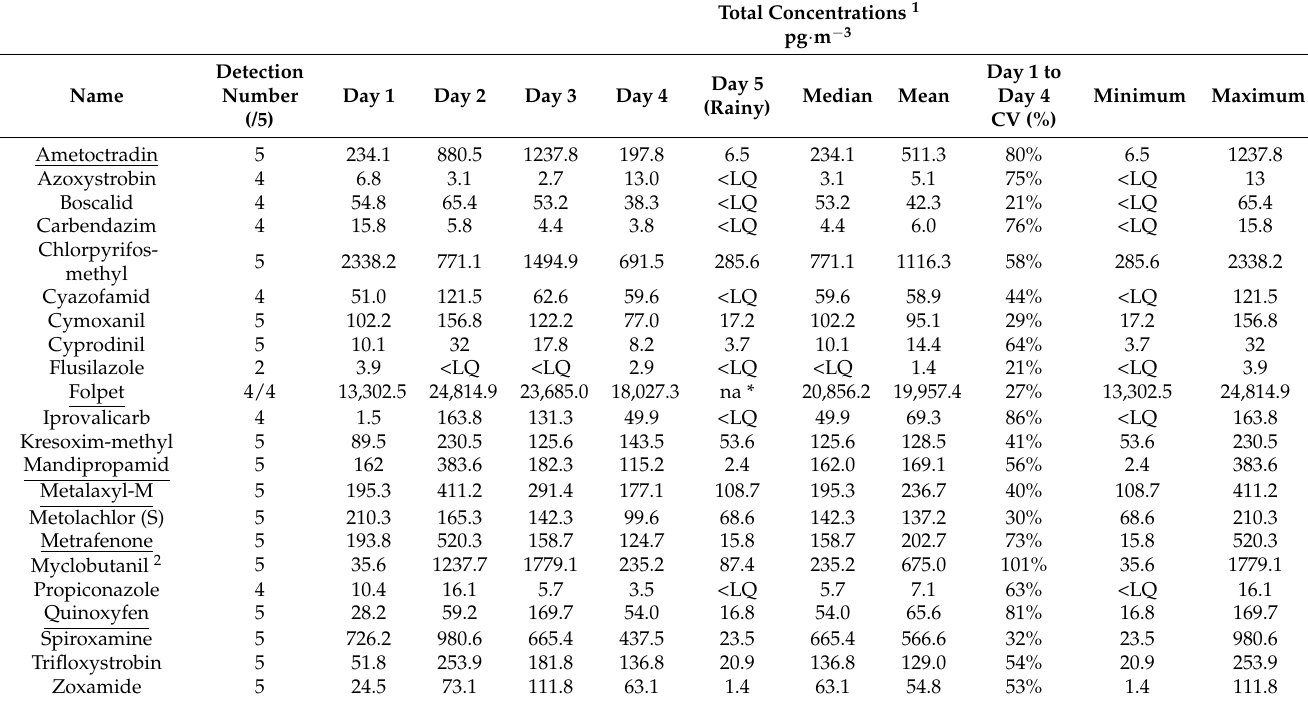
Table 2. Number of detections, median, minimum, maximum, and total concentrations (pg m − 3 ) of pesticides detected using HV-AAS. Total Concentrations 1 pg · m −